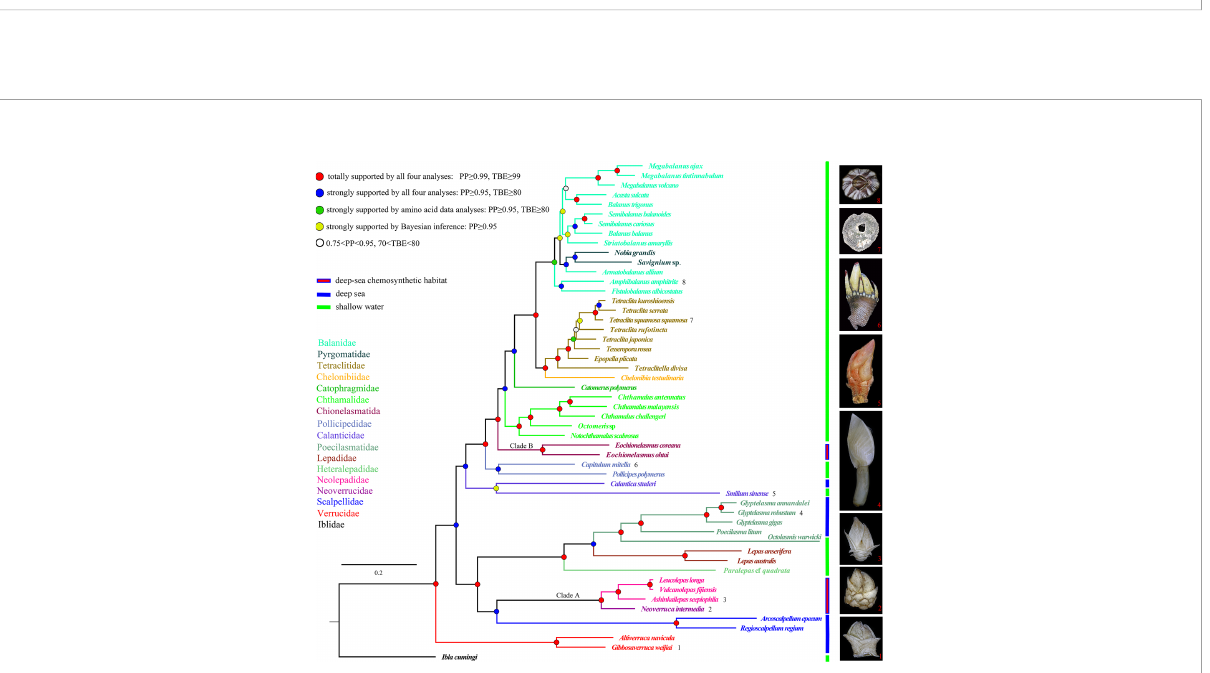
FIGURE 2 Phylogenetic topology inferred from the combined amino acid sequences of the complete mitogenomes of barnacles. Clades A and B indicate the two chemosynthetic barnacle lineages. The color of the species name and branch denotes the family classi fi cation of the taxon. The digits after the species name correspond to sample photos. Posterior probabilities (PP) and transfer bootstrap expectation (TBE) values from both the nucleotide and amino acid data are annotated using different colored